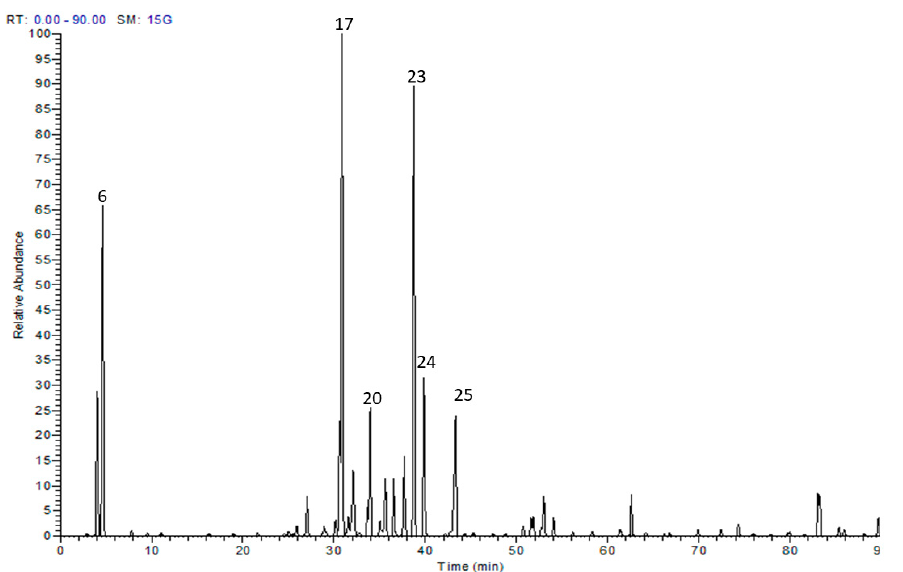
Figure 1. Liquid chromatography-mass spectrometry (LC-MS) base peak chromatogram of Salix tetrasperma flowers. Table 1. Secondary metabolites from Salix tetrasperma flower extract.